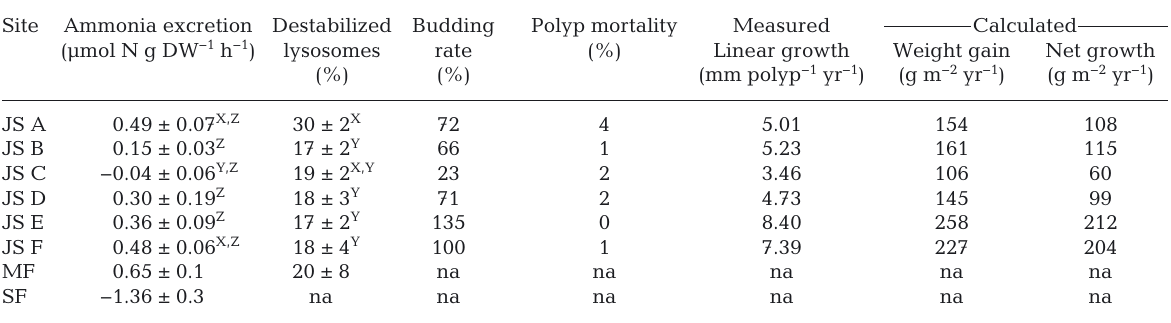
Table 2. Ammonia excretion rate and % destabilized lysosomes of collected coral colonies (mean ± SE, n = 6). Also shown is the growth (budding, mortality and linear growth) of transplanted corals and estimated calcification and net growth (taking into ac- count bioerosion) of Lophelia pertusa colonies along a gradient from the fish farm in Julsundet (JS). Different superscript letters show statistically distinct groups as identified by Tukey’s HSD test (p < 0.05). Weight gain estimated using the conversion factor